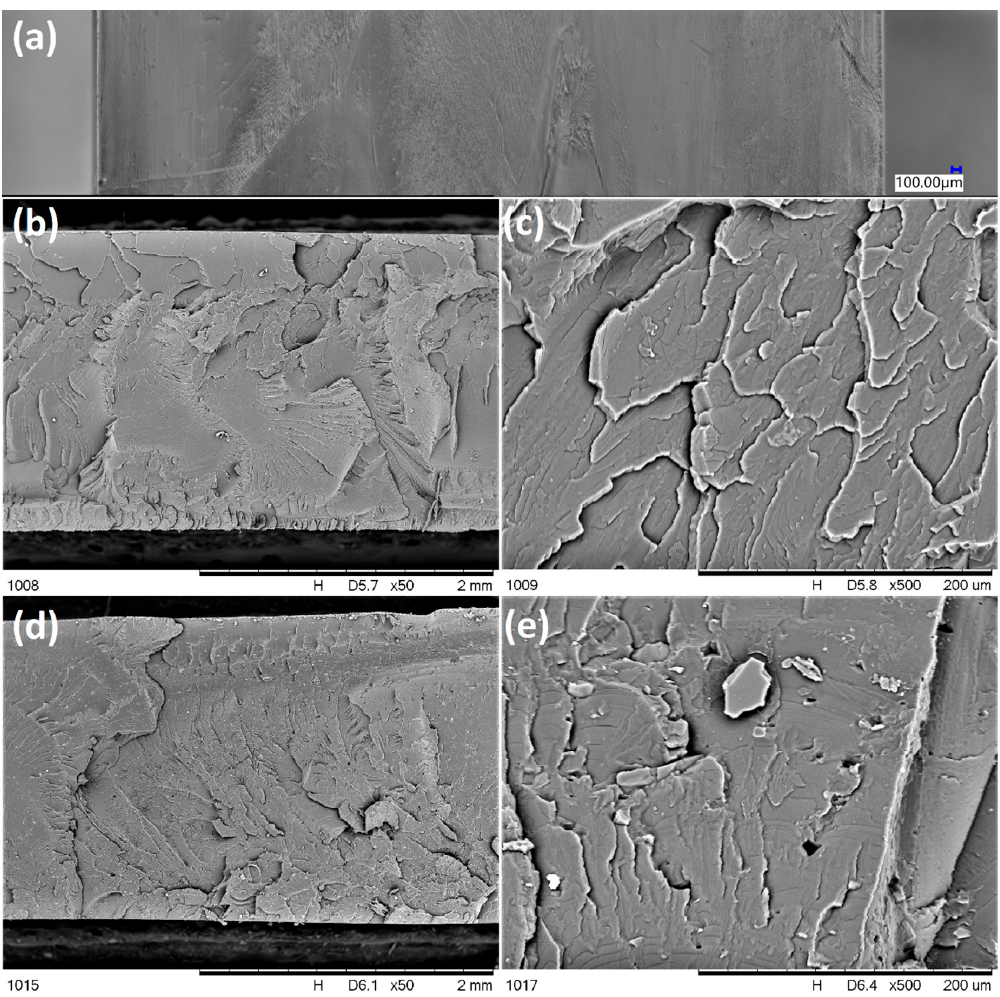
Figure 5. Optical microscopic image ( a ) and SEM images ( b – e ) of injection moulded samples: outer surface ( a ), fractured sample from neat PLA ( b , c ), fractured sample from 2.5% SS-Limonene/PLA ( d , e ).